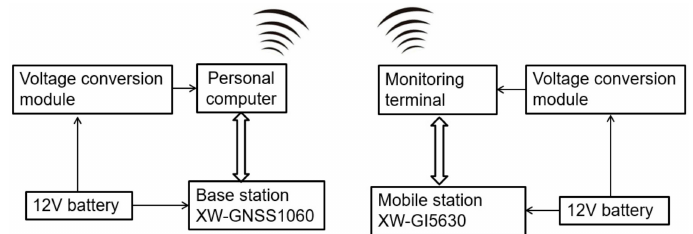
Figure 10. Sketch maps of connection between the base station and mobile station of the